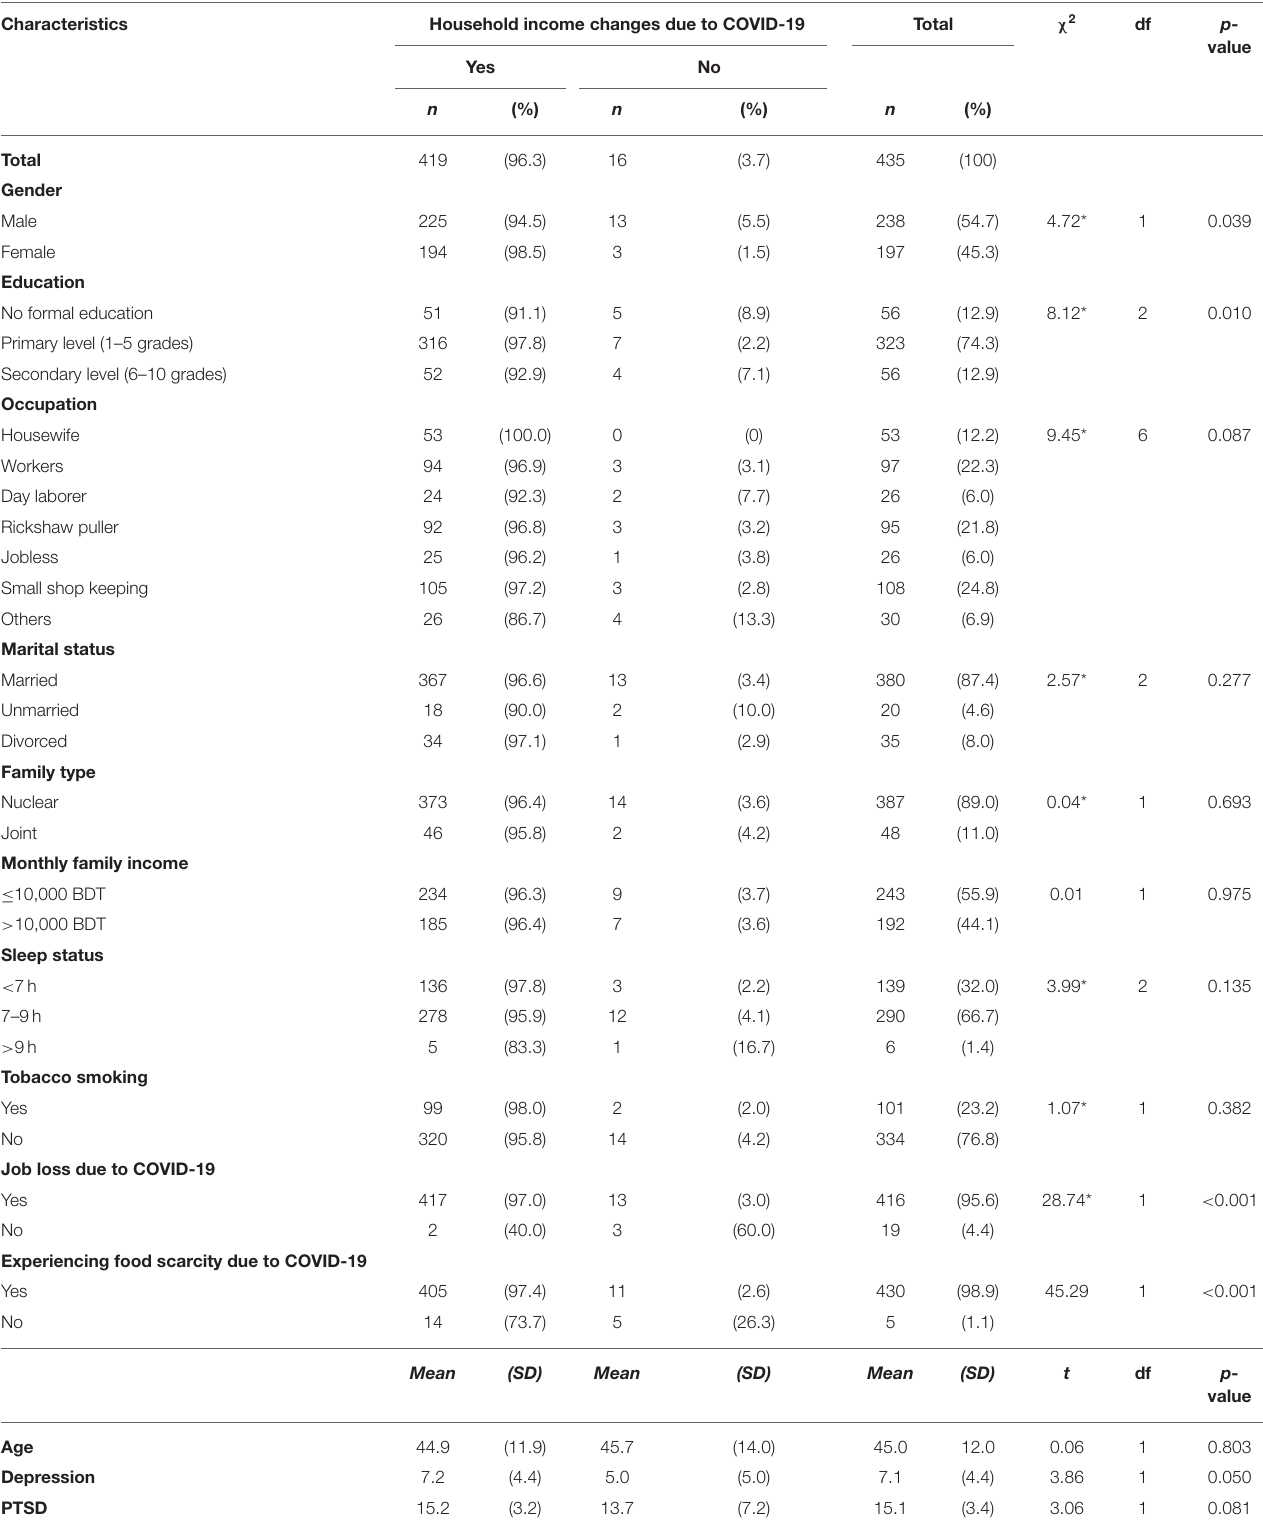
TABLE 1 | Measures and their associations with household income decreases due to the impact of COVID-19.